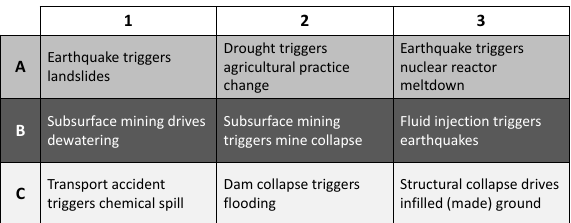
Figure 2. Interaction relationships (triggering) framework using a hazard/process flow diagram. A framework for hazard/process in- teractions is given here, which highlights triggering relationships between three groups: (A) natural hazards, (B) anthropogenic pro- cesses and (C) technological hazards/disasters. Arrows are used to illustrate interaction relationships, with the arrow fill colour indi- cating the source or initiation of the trigger (medium grey: natu- ral hazards; dark grey: anthropogenic processes; light grey: tech- nological hazards/disasters). We use a prime (A (cid:48) , B (cid:48) , C (cid:48) ) to indi- cate secondary hazards/processes triggered by the same primary hazard/process group (A, B, C). Arrows are labelled (A 1 –A 3 , B 1 – B 3 , C 1 –C 3 ) according to the hazard or process type of the trigger source (i.e. A, B, C) and followed by sequential subscript number- ing. Numbering starts (A 1 , B 1 , C 1 ) with the triggering relationship between the same primary and secondary hazard or process type (e.g. a primary natural hazard triggering a secondary natural hazard) and progresses clockwise. Examples of each interaction are given in the table at the bottom of the figure, where the vertical axis indicates the source of the primary hazard/process (A, B, C) and the horizon- tal axis indicates which subscript is being referred to (1, 2,